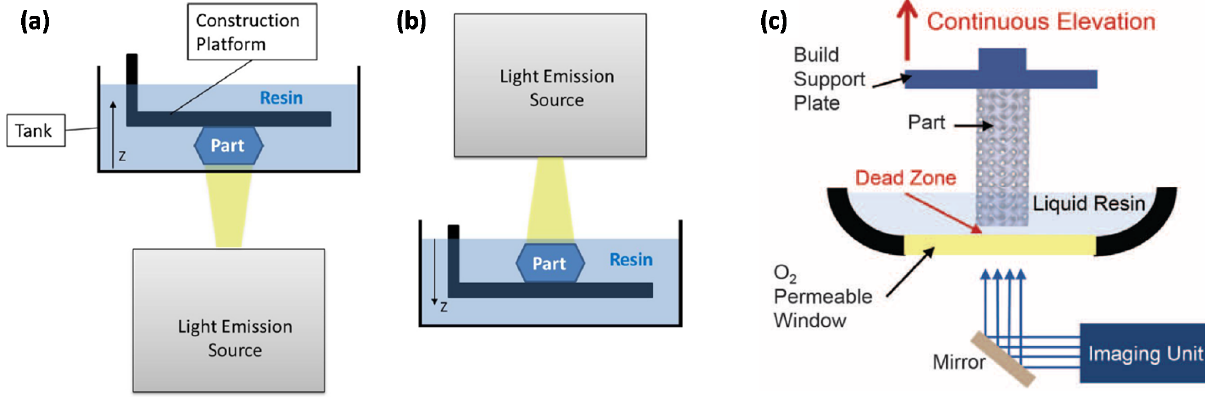
Figure 2. Schematics of digital light processing (DLP) following bottom-up ( a ) and top-down ( b ) approaches, and ( c ) contin- uous liquid interface polymerization (CLIP). ( a , b ) have been reprinted from [7] with permission from Elsevier, and ( c ) has been reprinted from [5] with permission from the American Association for the Advancement of Science.